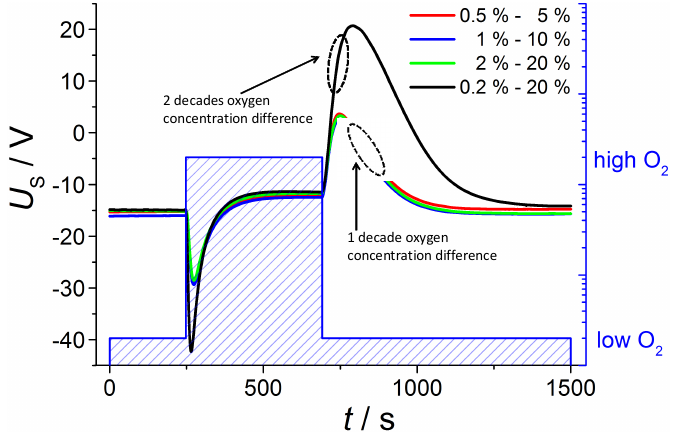
Figure 5. Voltage recording at changing oxygen concentrations with different concentration steps (one decade oxygen in contrast to two